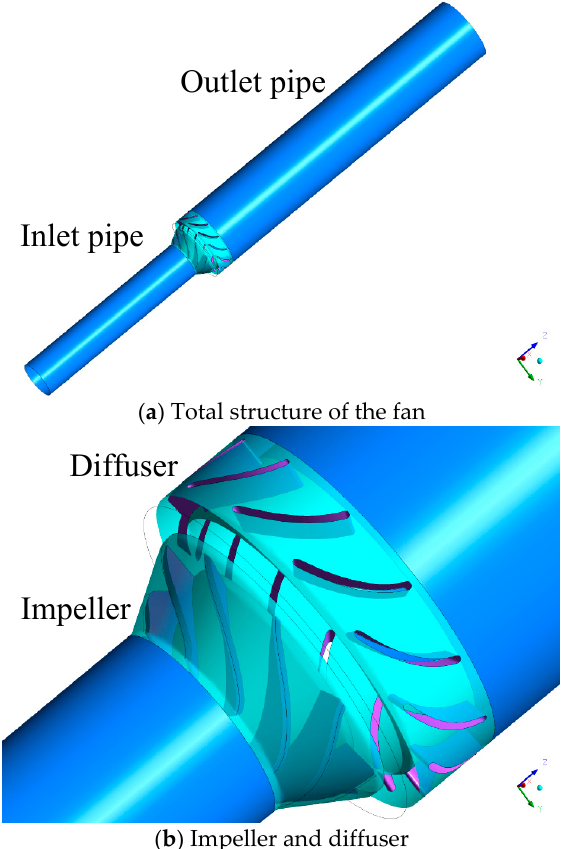
Figure 1. Structure of the fan. ( a ) Total structure of the fan; ( b ) Impeller and diffuser.